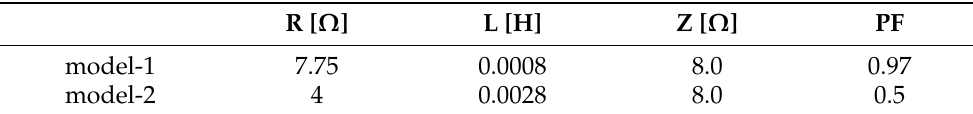
Table 6. 20 kVA/400 V load models simulation parameters.